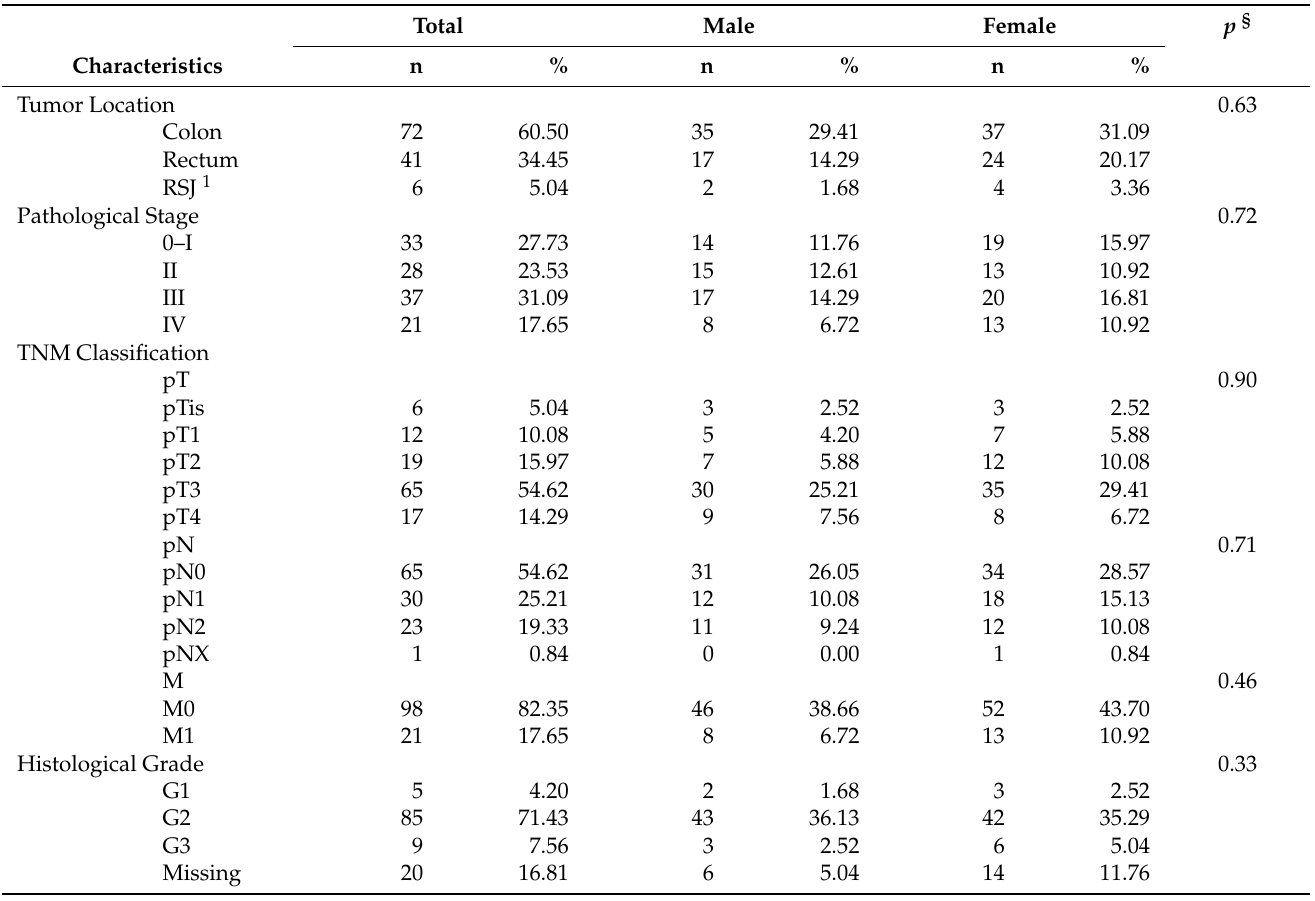
Table 2. Clinico-pathological characteristics of case group (N = 119). Total Male Female p